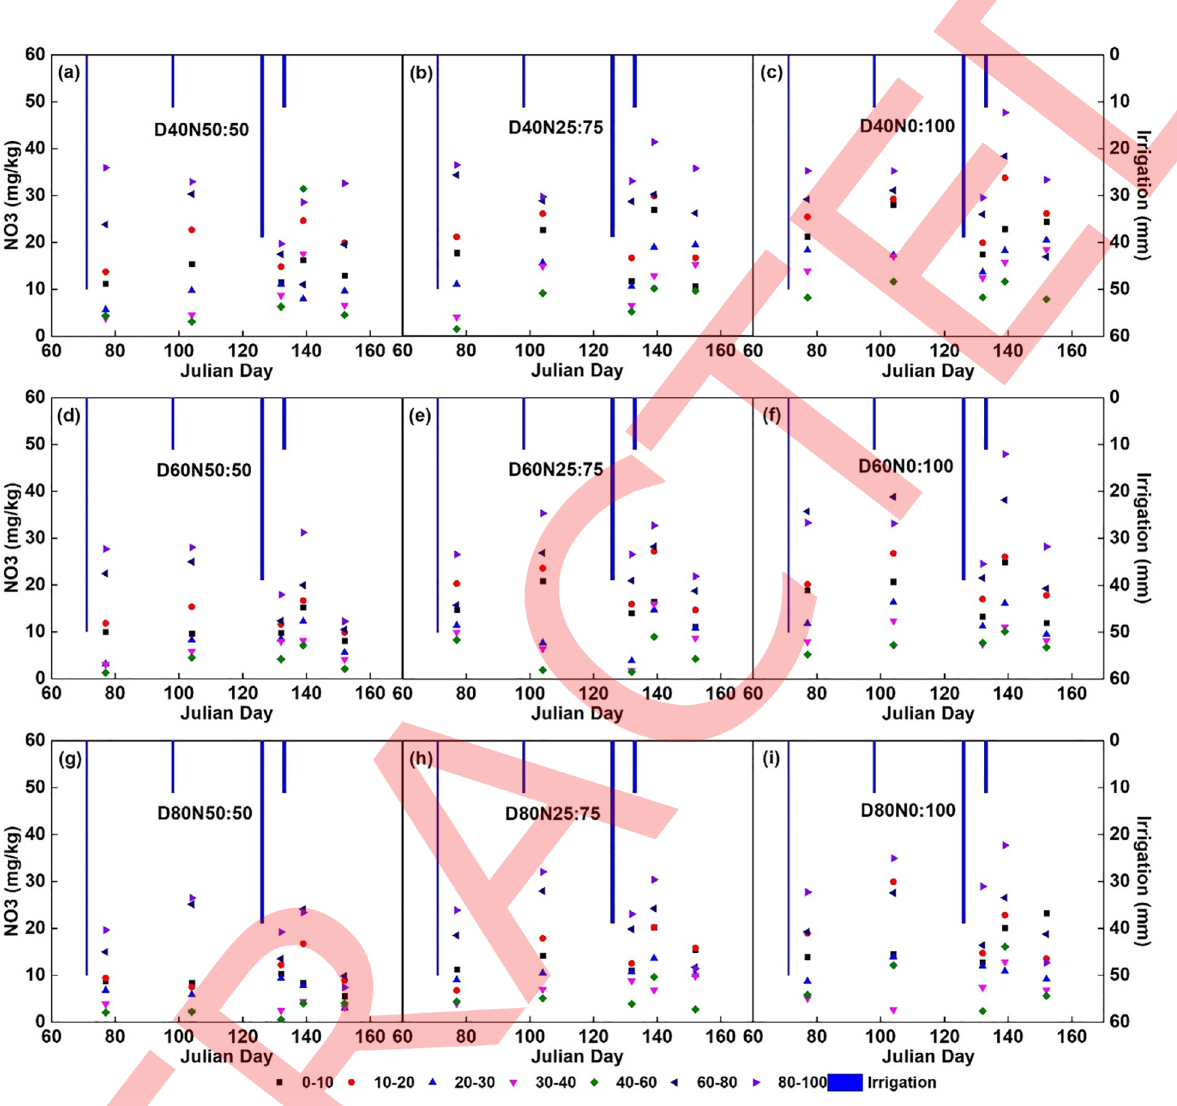
Fig 4. Soil NO3—N contents of various LS and NAMs during the 2018 wheat growing